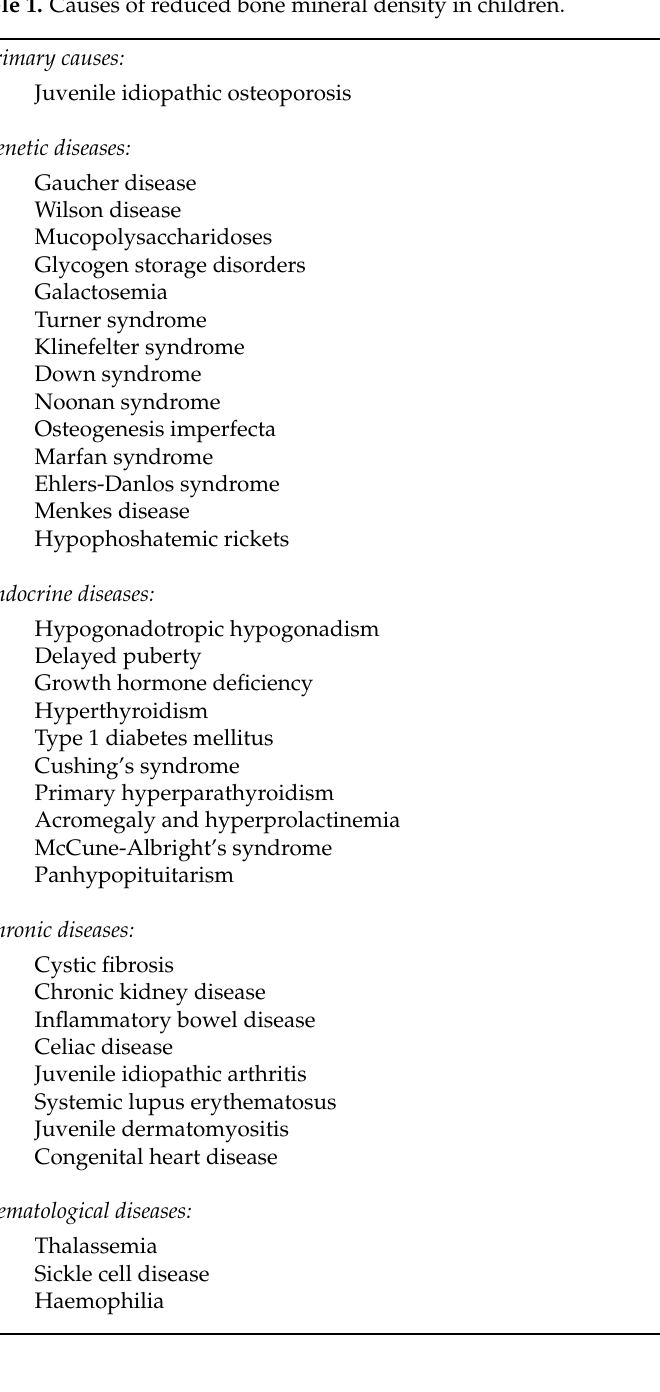
Table 1. Causes of reduced bone mineral density in